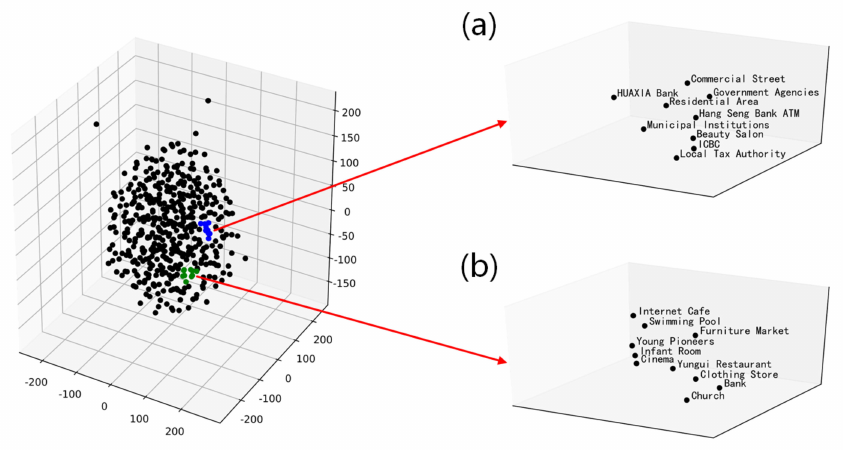
Figure 3. POI type vectors in three-dimensional semantic space, with example local types that are close to each other ( a , b ).